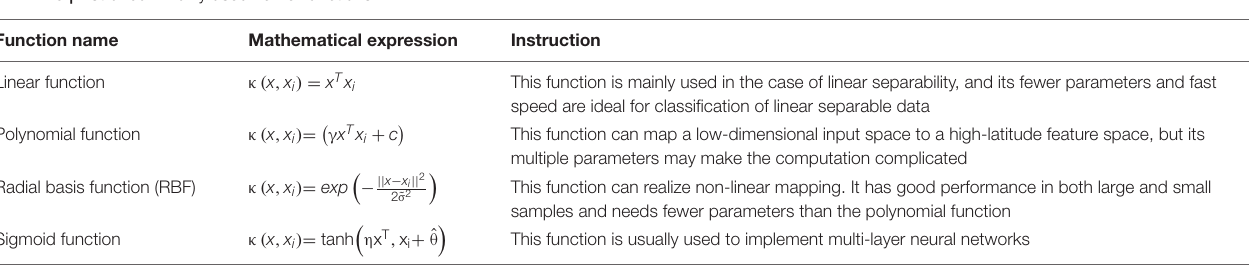
FIGURE 5 | Diagram of an n -layer neural network. In this neural network, i is the number of layers and j is the number of units in each layer. x 1 , x 2 , ... , x m represent input units, while y 1 , y 2 , ... , y k represent output units. a ( i ) j represents the j -th activation unit in the i -layer, which is responsible for mapping the input of a neuron to the output. (cid:50) ( i ) represents the weight from the i -th layer to the i +1-th layer, whose function is to adjust the proportion of each input value before entering the activation function. Furthermore, we sometimes add a bias unit to each layer to reduce the error of the output value. TABLE 3 | List of commonly used kernel